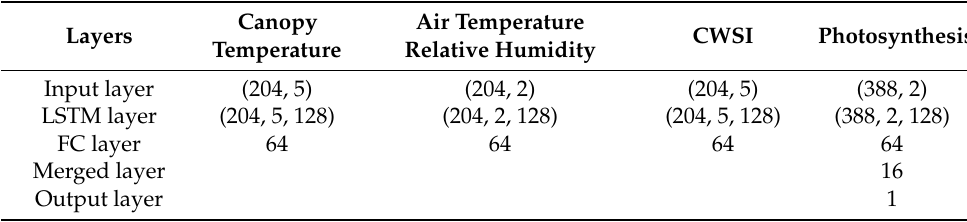
Table 1. MSLTM model